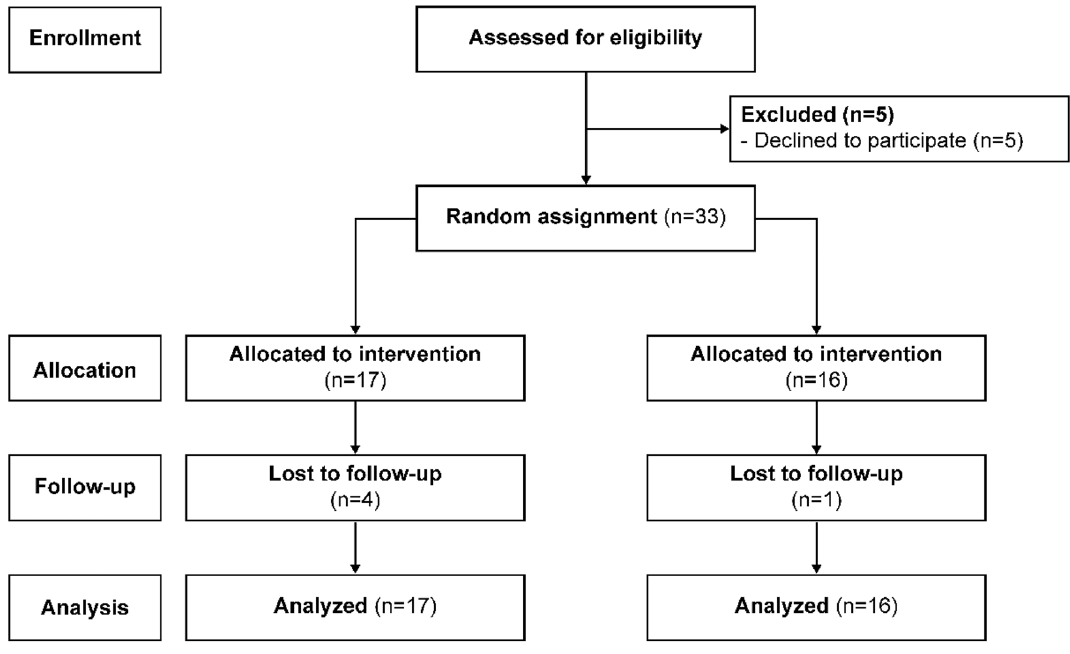
Figure 3. Participant flow